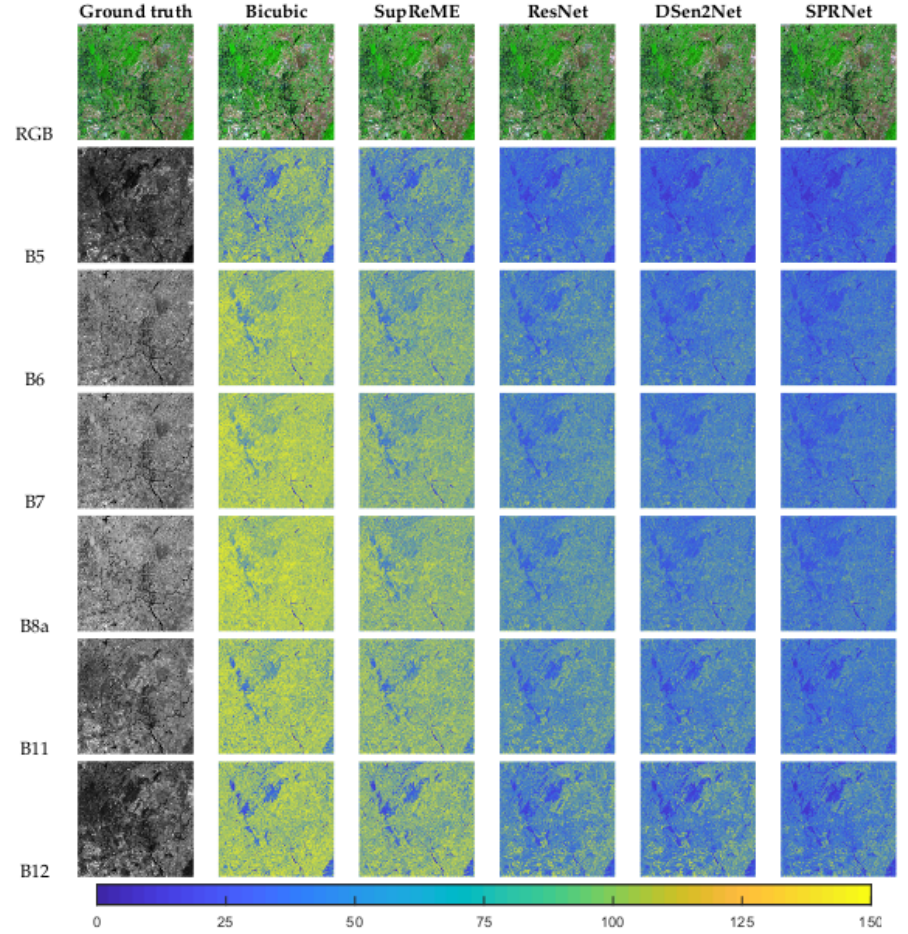
Figure 5. Absolute differences between ground truth and sharpening results on site 1 at lower scale (input 40 m output 20